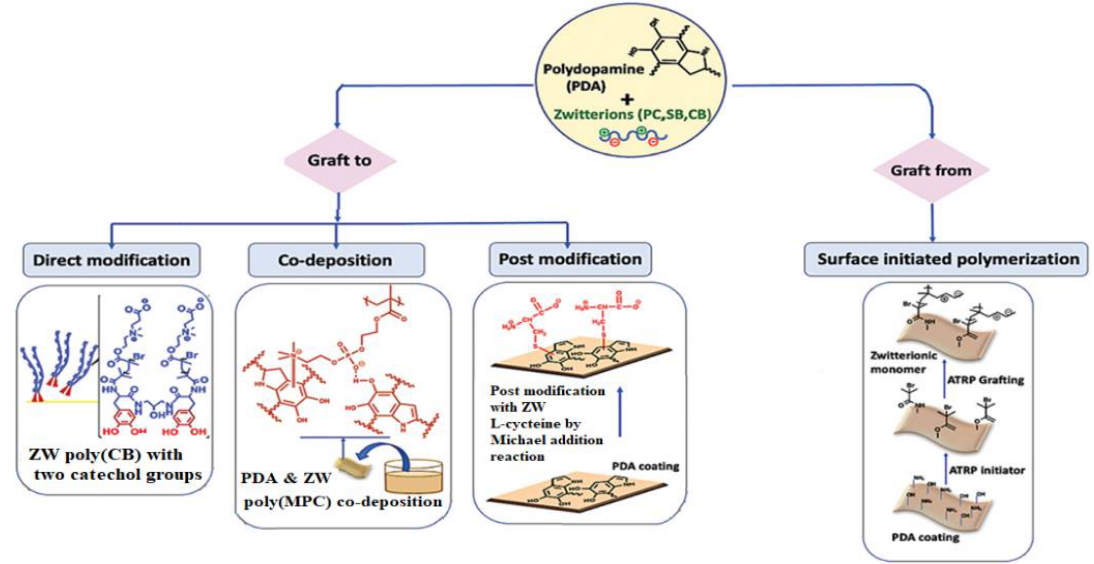
Figure 10. Different techniques of dopamine zwitterion conjugation [182].